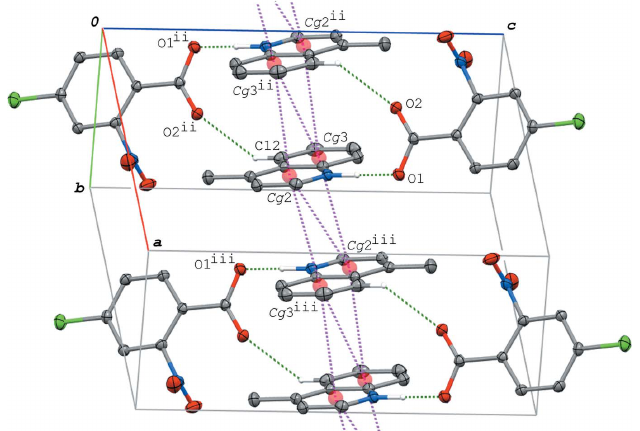
symmetry code as given in Table 7], forming a centrosym- metric dimeric unit. The dimeric units are further linked into a ribbon structure along the b- axis direction (Fig. 11) via other